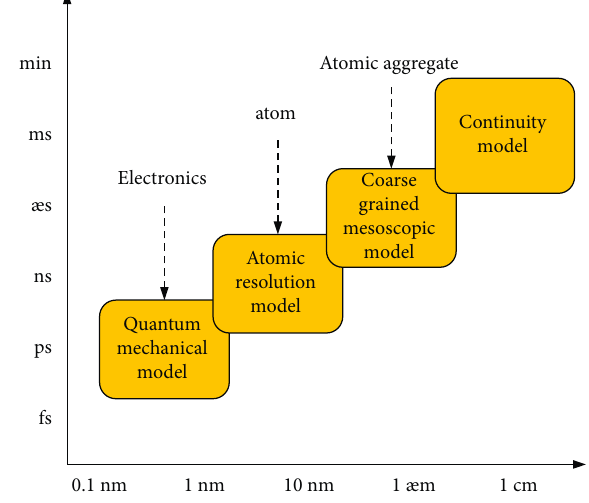
Figure 4: Brief introduction of commonly used molecular dy- namics simulation methods on different time and space